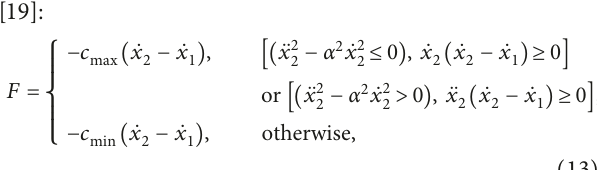
Figure 10: Model of semiactive controller in